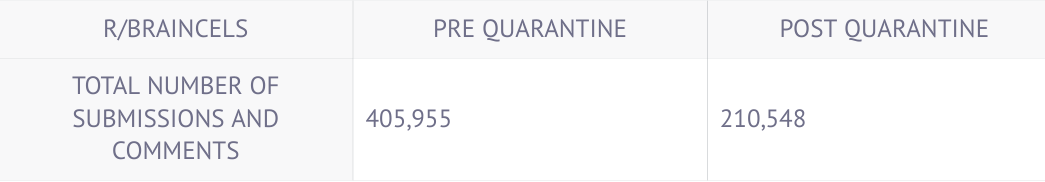
TABLE 2: Misogynistic language analysis for r/Braincels